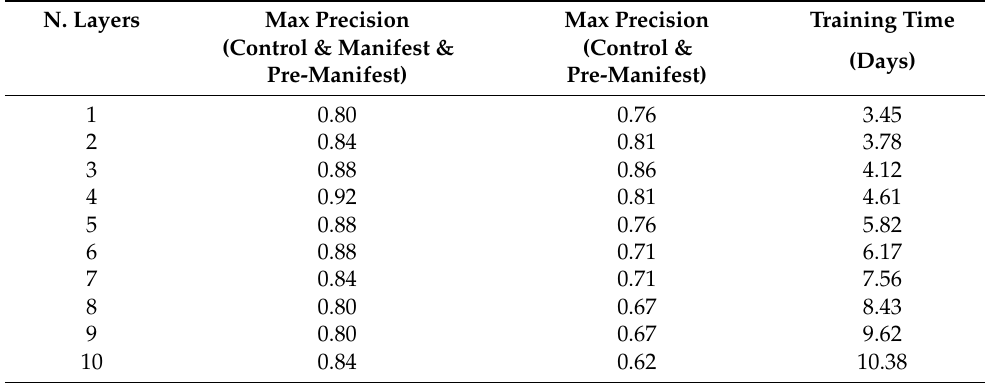
Figure 2. Forecasting accuracy and required computational time using different ANN architectures. The second part of the algorithm further increased the accuracy of the forecasts. The best results are, similar to the previous case, obtained when using an artificial neural network with four layers (Table 1). Deeper artificial neural networks, such as the one using ten hidden layers, did not improve the results obtained using four layers. The sensitivity and specificity (Table 2) were 0.95 and 0.80 respectively with a final list of 237 CpGs, representing a very substantial reduction from the initial 485,512 available CpGs. The complete 237 CpG list can be found in the supplementary material. Controlling for age and body mass index did not impact the classifications obtained. Table 1. Forecasting precision obtained with the different neural network configurations (after the second part of the algorithm). The second column shows the results using control, pre-manifest and manifest cases while the third column includes only control and pre-manifest cases. The fourth column shows the computational time required for training the neural network.